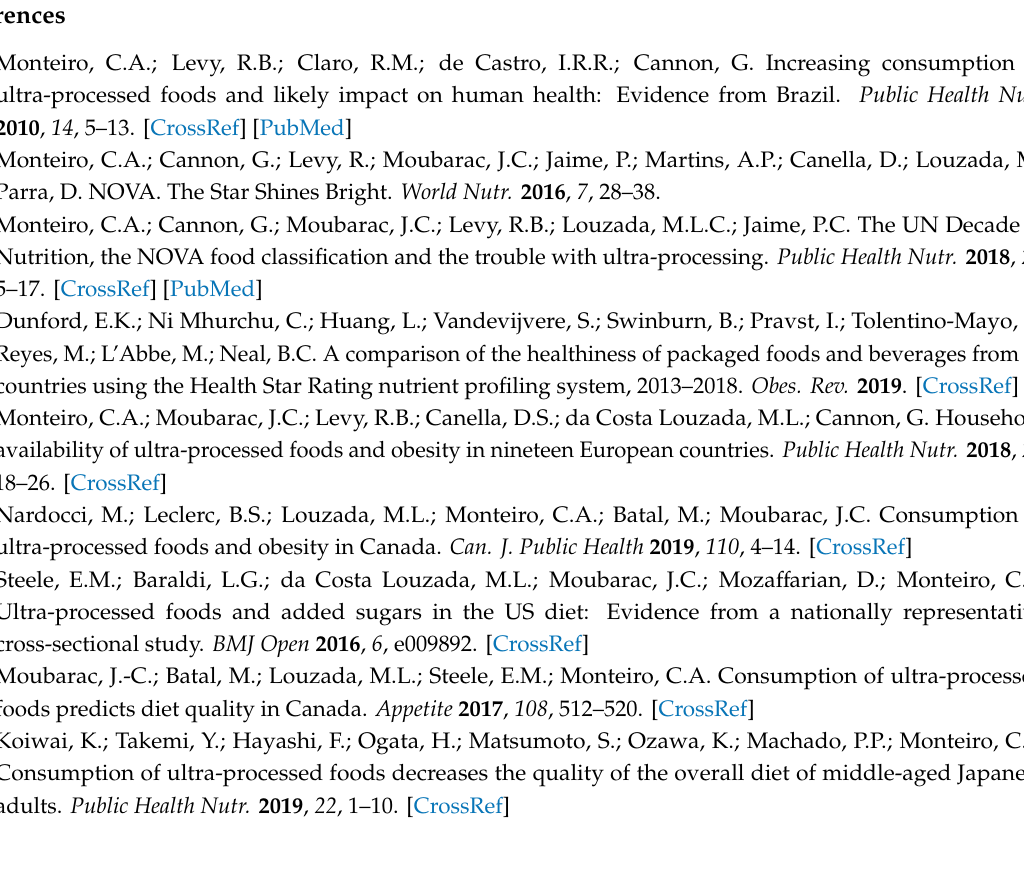
Supplementary Table S1: Mean total and mean free sugar content (in g per 100 g or mL) of pre-packaged food products in 2017 divided by food